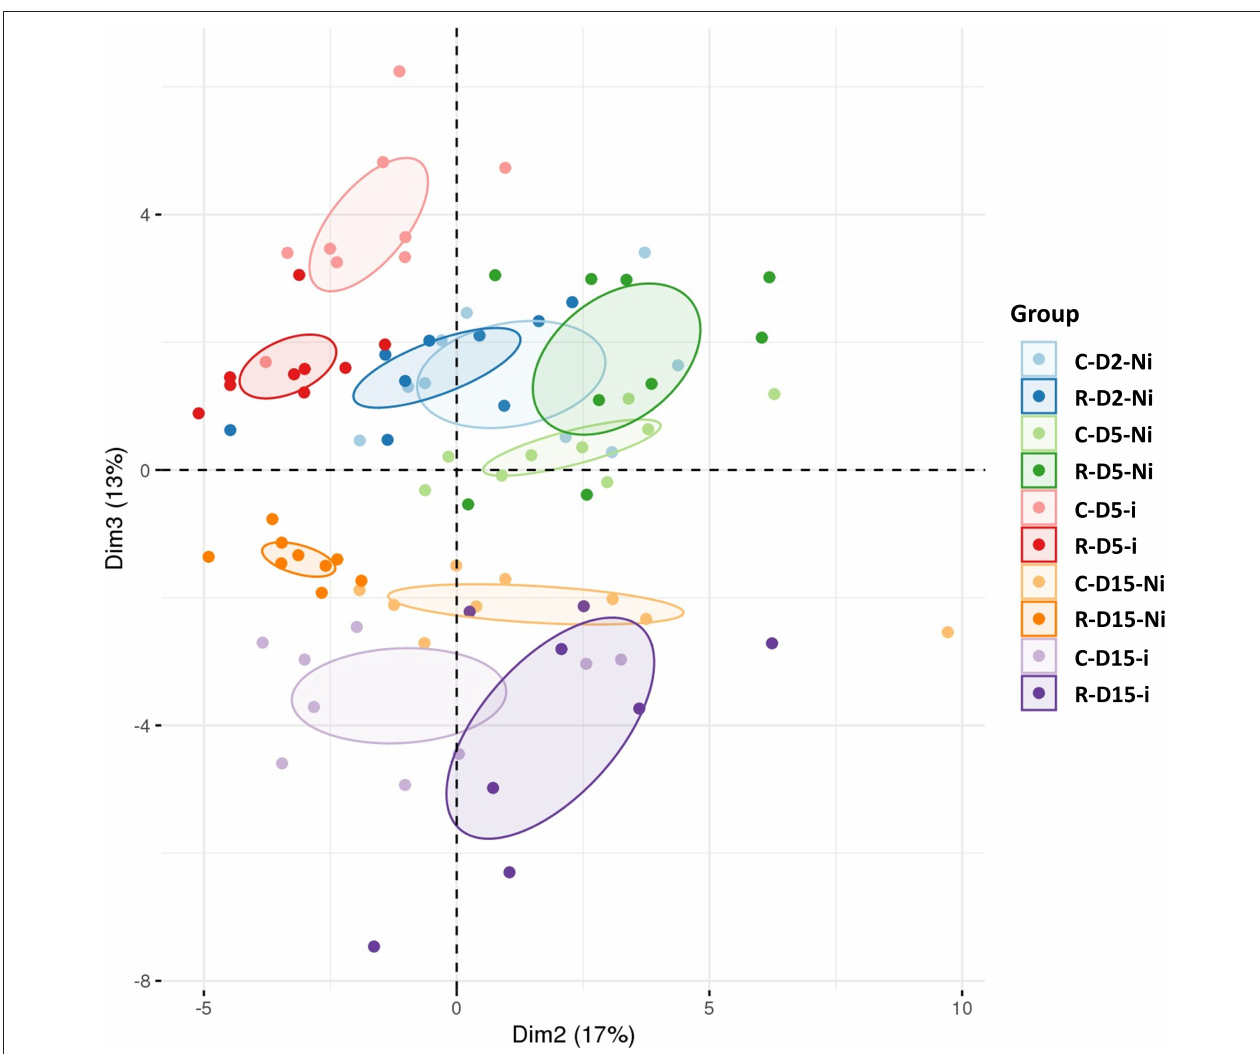
FIGURE 5 | Principal component analysis (PCA) of targeted metabolomic data sets from wheat leaves treated or not with Rh-Est-C12 and/or inoculated with Z. tritici . For each modality, nine biological replicates were used. The second and the third principal components explain 17 and 13% of the variance separating the groups of samples, respectively. C stands for a mock treatment, while R is for Rh-Est-C12 application; Ni relates to mock-inoculated wheat, while i means inoculated plants with Z. tritici ; D2, D5 or D15 indicates sampling dates of the third leaves, corresponding to 2, 5, or 15 days after treatment,